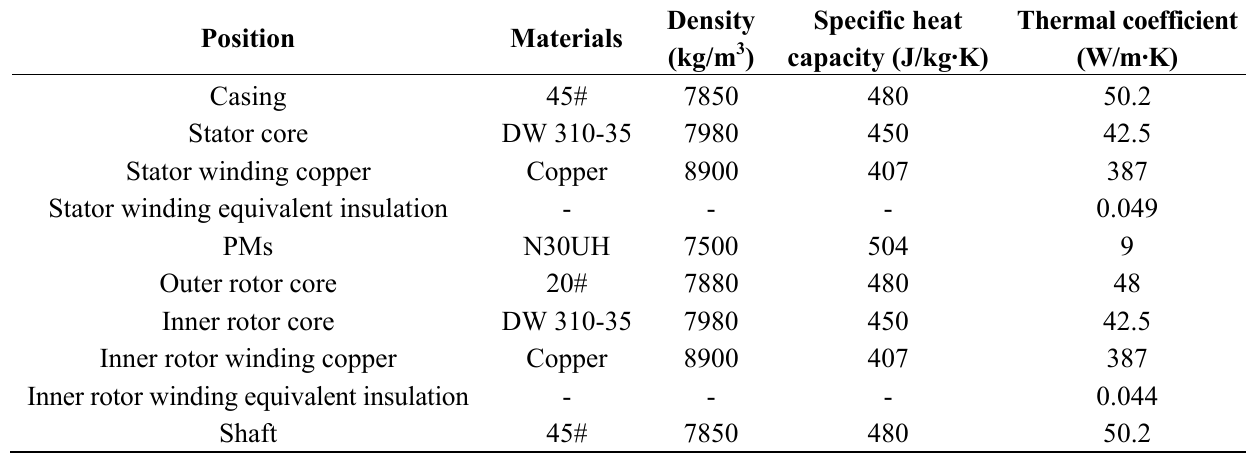
Table 5. Thermal parameters of the machine materials and cooling fluids.